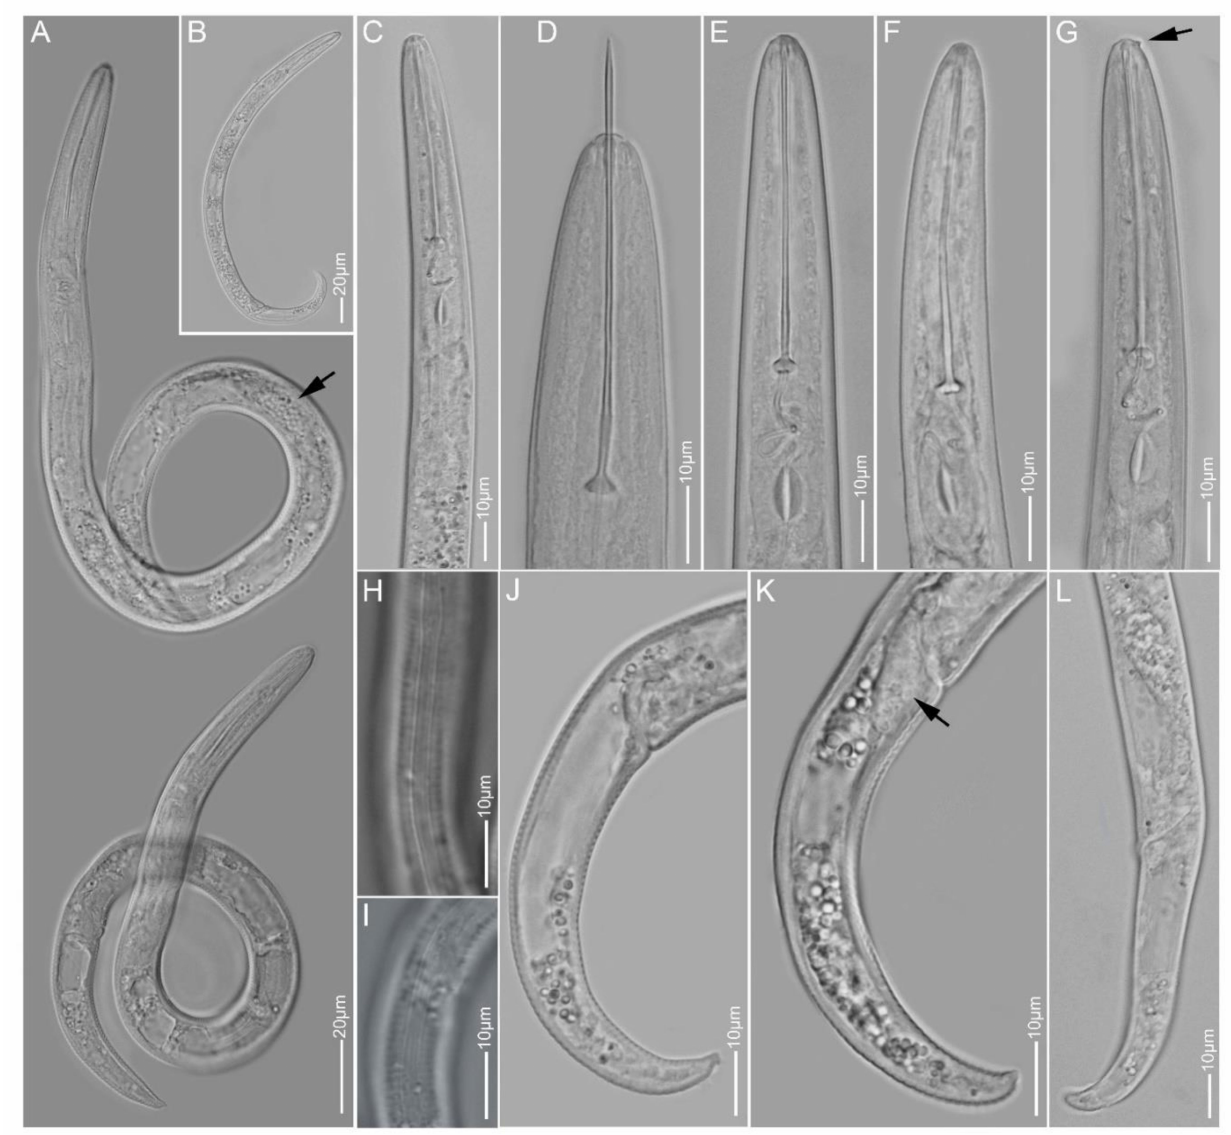
Figure 3. Light microscopy images of Paratylenchus goodeyi females: ( A , B ) total body; ( C – G ) anterior region; ( H , I ) lateral field; ( J – L ) tail region; arrows pointed to spermatheca in A, protruding submedian lobe in G and post-vulva sac in